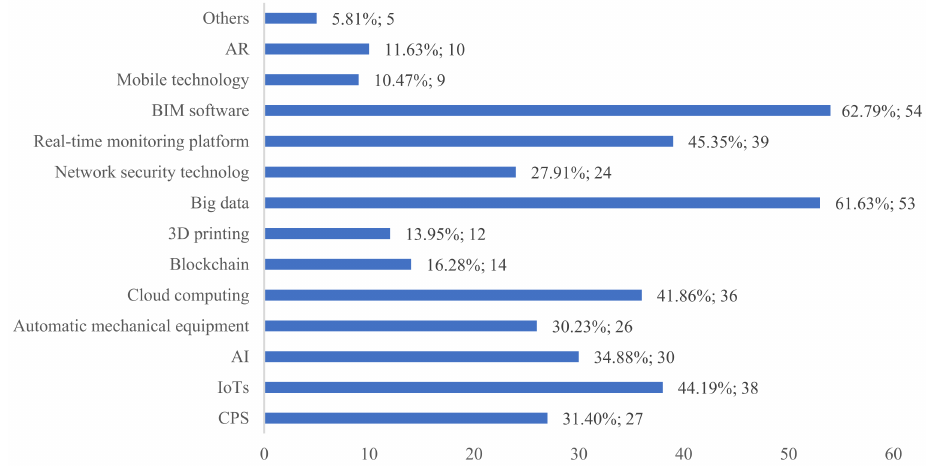
Figure 1. The status of digital technology